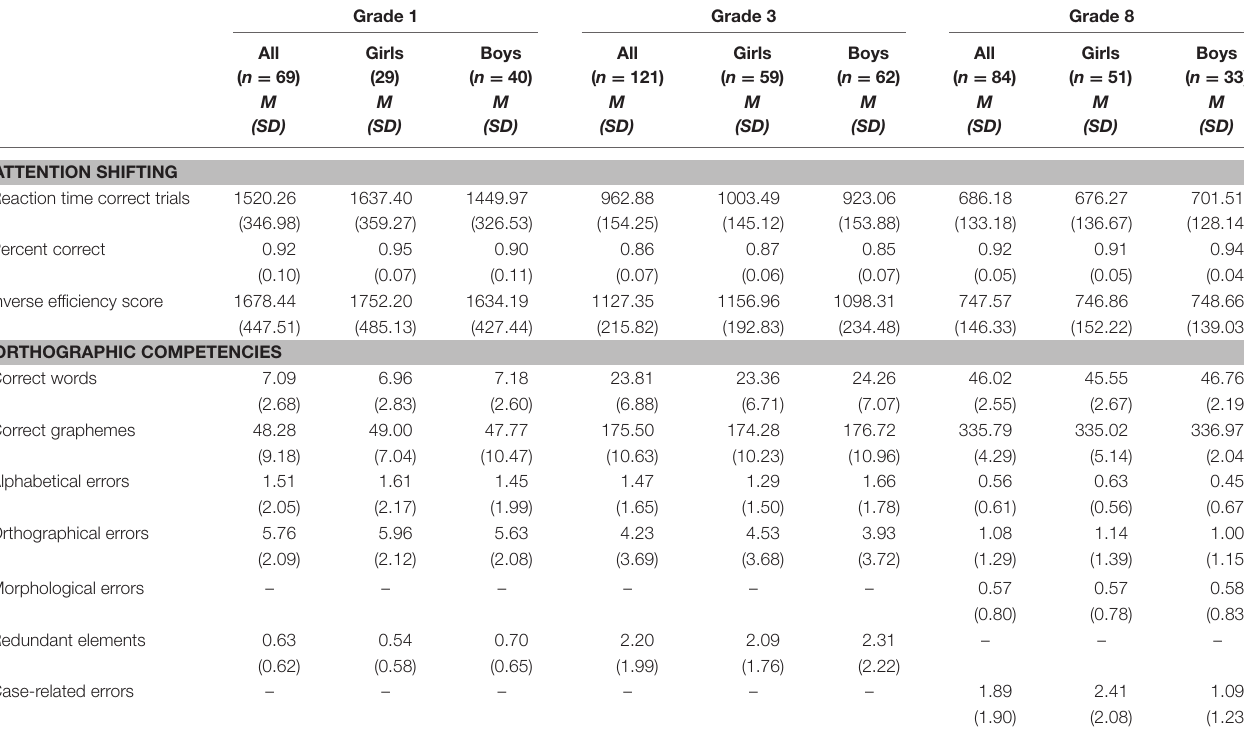
TABLE 1 | Descriptive statistics for variables of